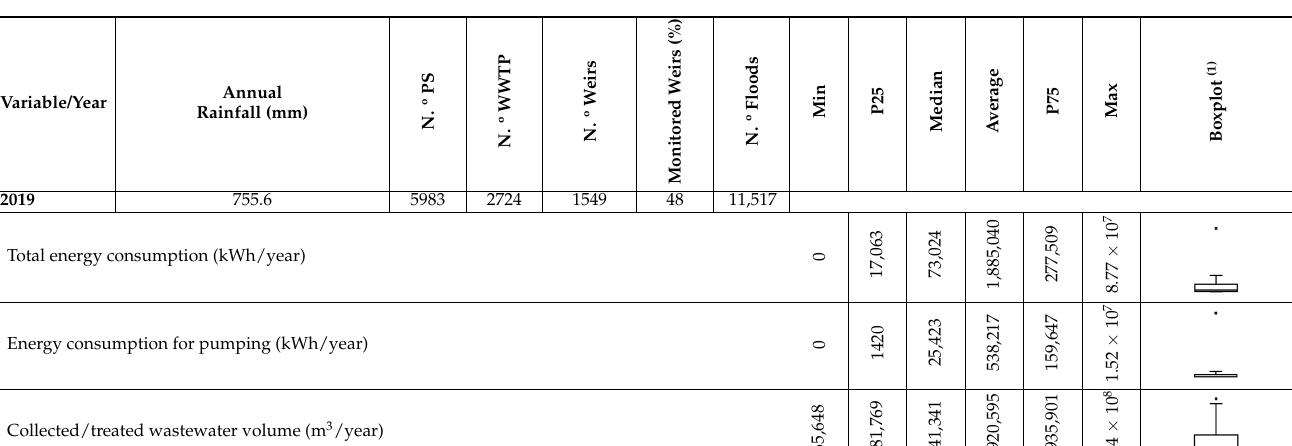
Table A6. National characterization for the evaluation of the W ‐ E ‐ G nexus for 2019.